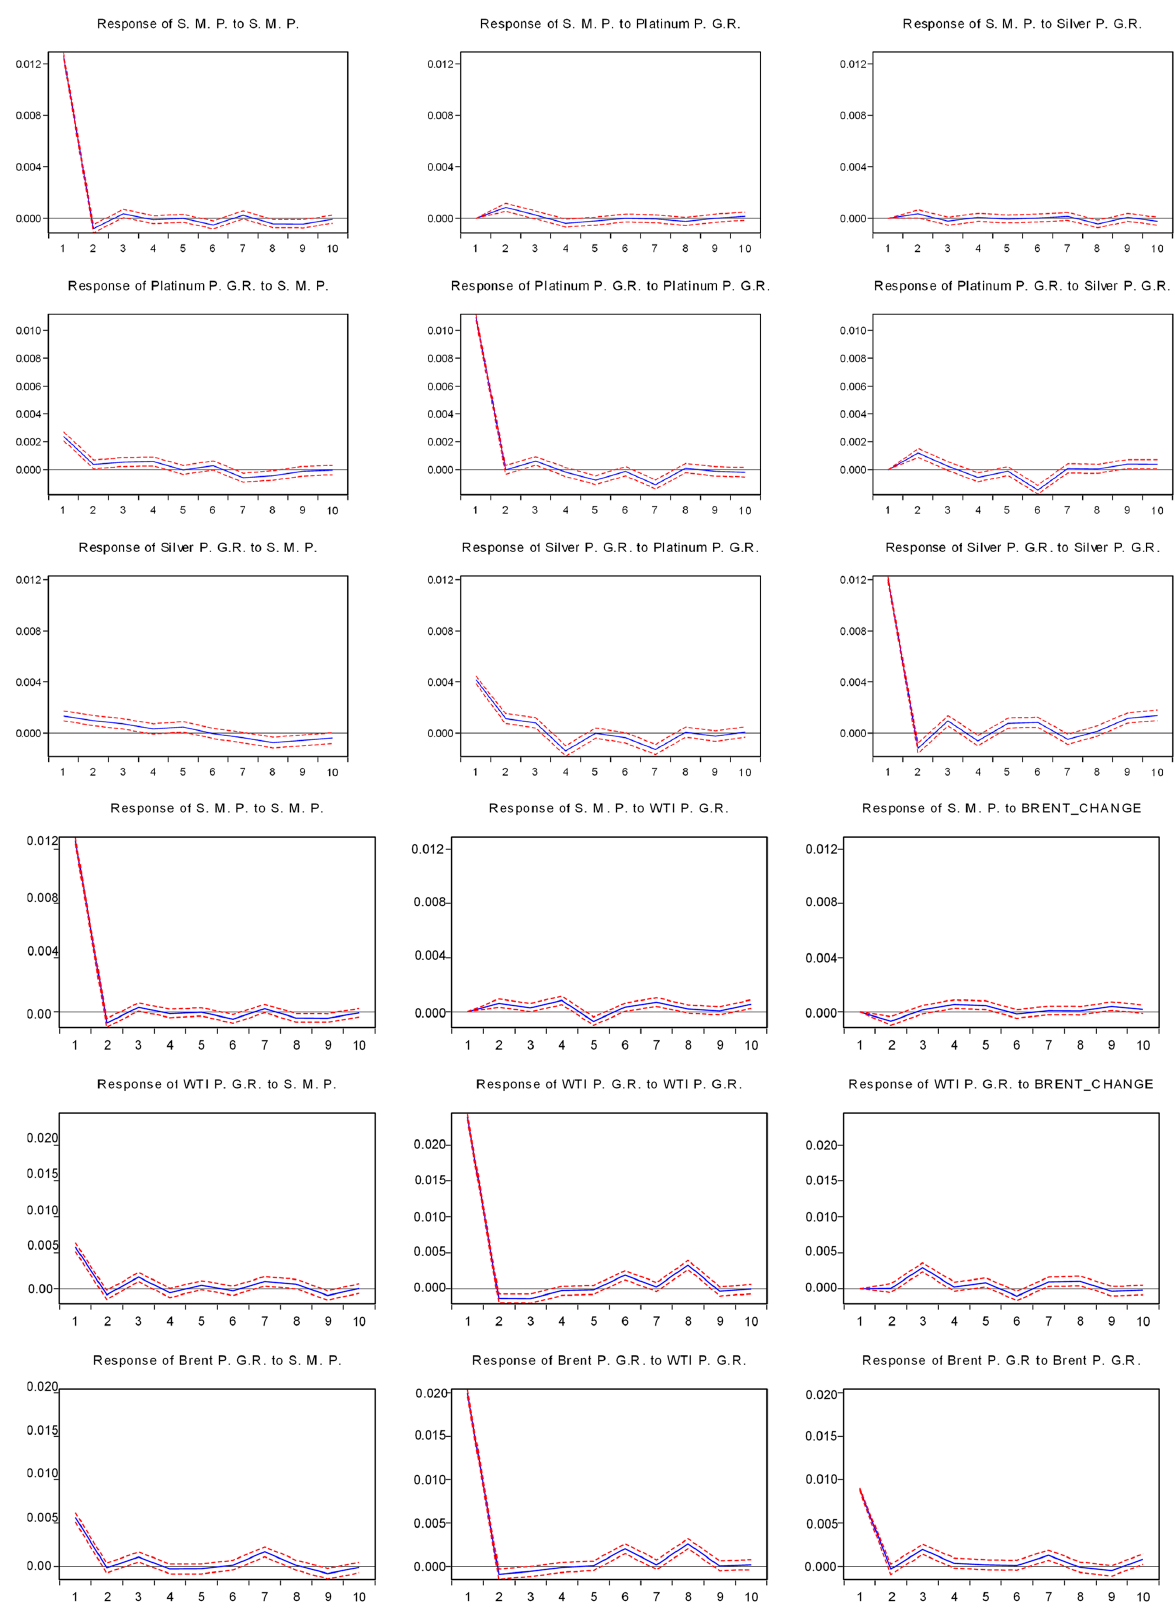
Figure A2. Estimated Impulse-Response Function. Note: Response to Cholesky One S.D. (d.f. adjusted) innovations ± 2 S. E. Source: Own Elaboration.